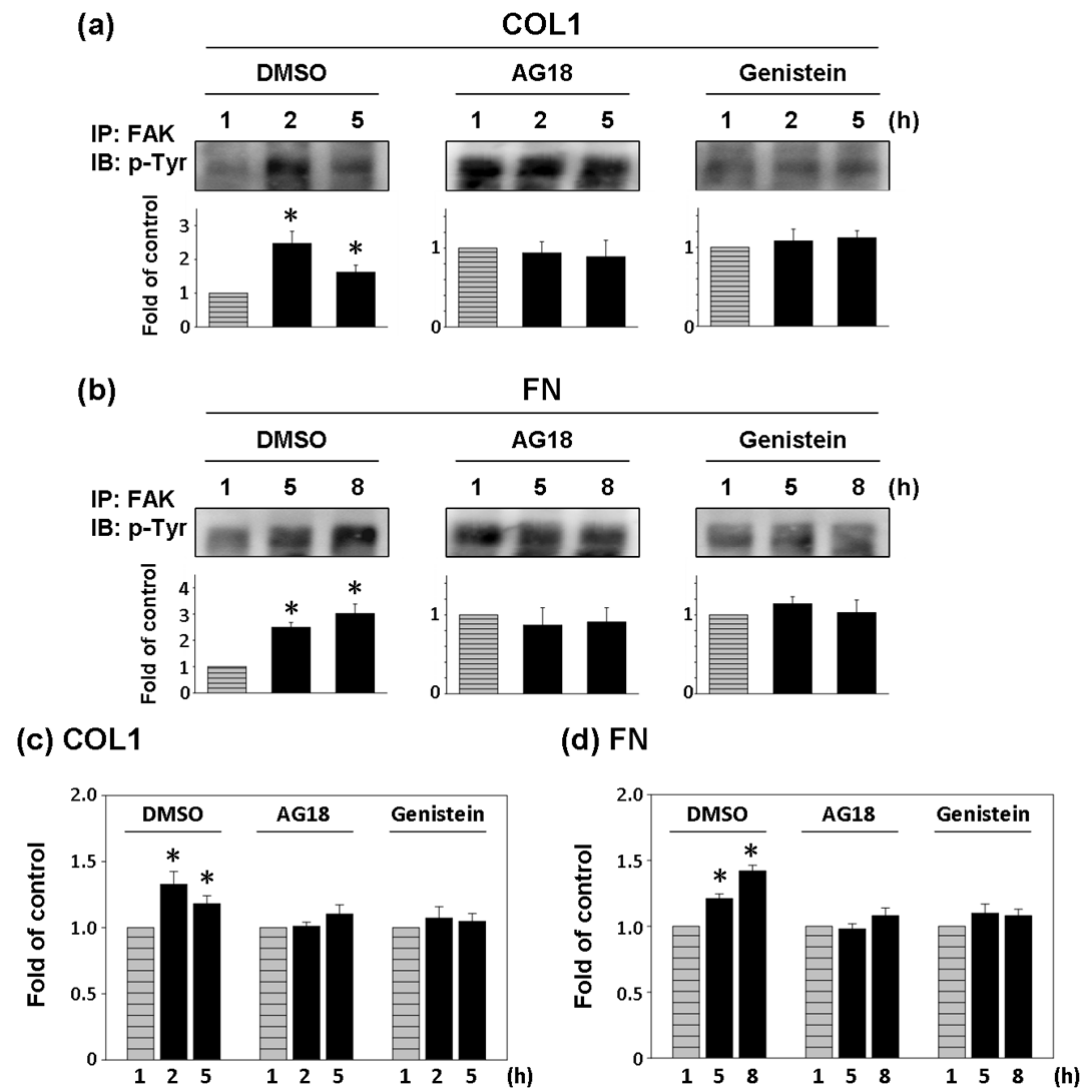
Figure 5. Effect of tyrosine kinase inhibitors, AG18 and Genistein, on COL1 and FN-mediated phosphorylation of FAK and cell adhesion strengthening. FAK phosphorylation and cell adhesion strengthening at first hour cultivation was used as control. ( a ) and ( b ) Cells were pretreated respectively with DMSO, AG18, and Genistein for 1 h and then cultured on ( a ) COL1- or ( b ) FN-coated PDMS membranes in the presence of DMSO or inhibitors as times indicated. Cells were collected from indicated time points and lysed by lysis buffer and immunoprecipated with FAK antibody. Phosphorylated FAK level was presented as band densities (normalized to immunoprecipitated FAK protein level) relative to control. IP, immunoprecipitation; IB: Western immunoblotting. * p < 0.05 versus control (first hour). ( c ) and ( d ) Cells were pretreated respectively with DMSO, AG18, and Genistein for 1 h and then cultured on ( c ) COL1- or ( d ) FN-coated PDMS membranes in the presence of DMSO or inhibitors as times indicated. Cell detachment force of indicated time points was detected by DEP force measurement system normalized to cell adhesion strengthening at first hour cultivation (which was assigned a value of 1 arbitrary unit). * p < 0.05 versus control (first